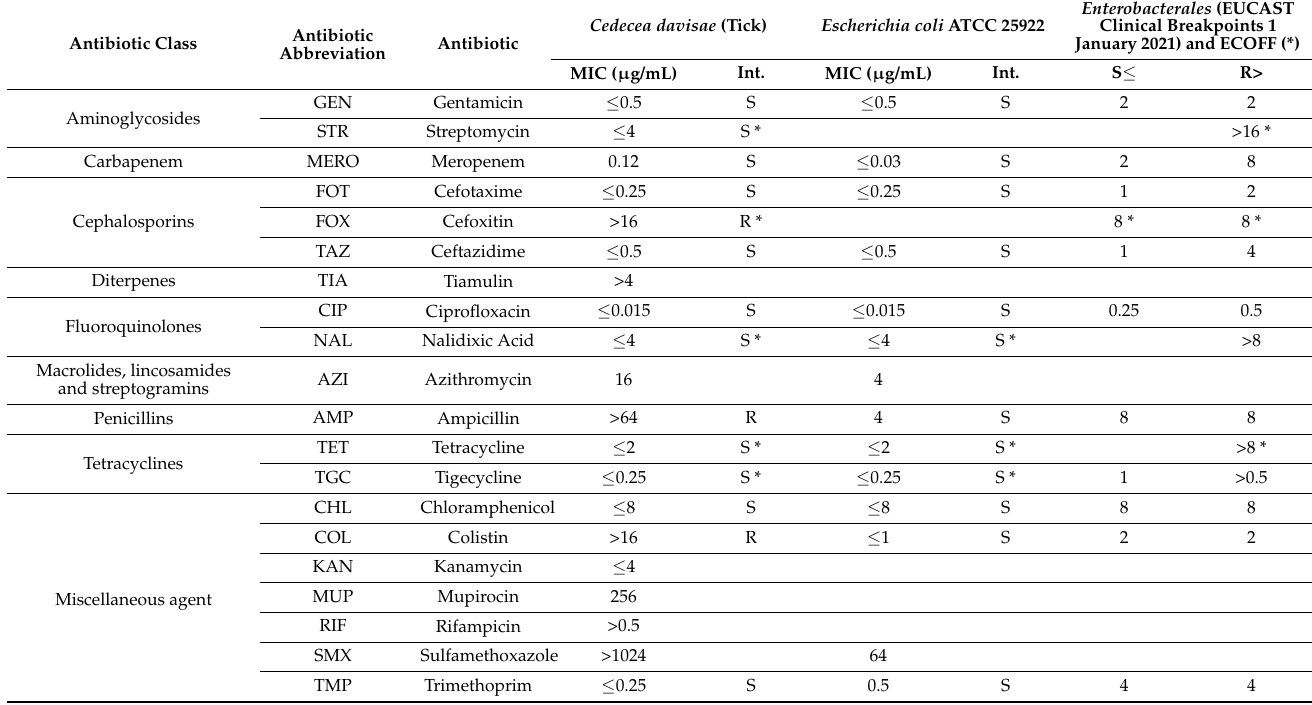
Table 5. MIC ( µ g/mL) values for the tick-derived C.davisae isolate as defined with the microdilution method Interpretation is based on clinical breakpoints defined by EUCAST (http://www.eucast.org/clinical_breakpoints accessed on 1 January 2021) or ECOFF (indicated by asterisks). Int. stands for interpretation, R. for resistant and S. for